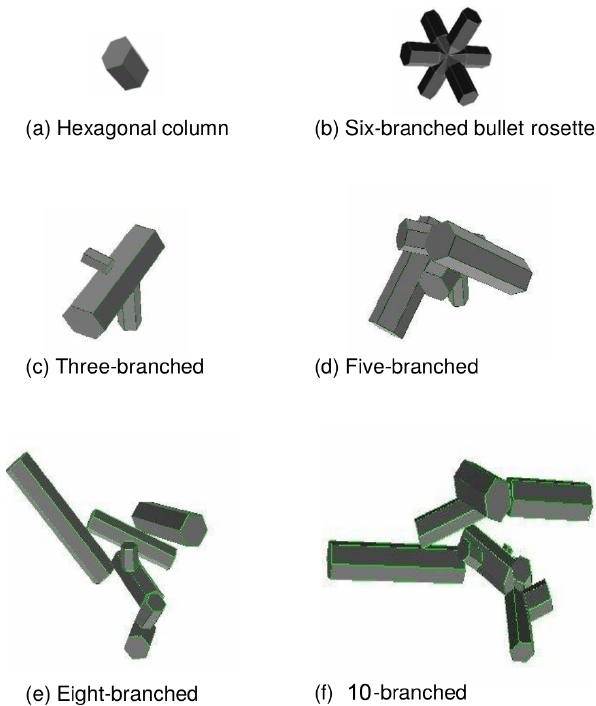
Figure 1. The ensemble model of Baran and Labonnote (2007). (a) Hexagonal ice column that represents the smallest member. (b) Six-branched bullet rosette. (c) Three-branched ice crystal. (d) Five-branched ice crystal. (e) Eight-branched ice crystal. (f) The 10-branched ice crystal, which represents the largest member (cour- tesy of Baran et al.,